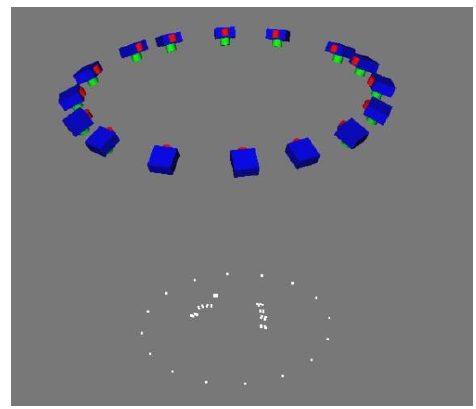
Figure 7. The photogrammetric network: 16 camera stations, the object control points on the plate and a model with 8 implants A first series of tests has been carried out with a Nikon D100 (6 Mpix, image format of about 23x15.6 mm) with 18 mm and 50 mm lenses; after some trials with stations including either convergent and nadir images, a single ring of 16 convergent images was found to be the best compromise between precision and number of images (see Figure 7).